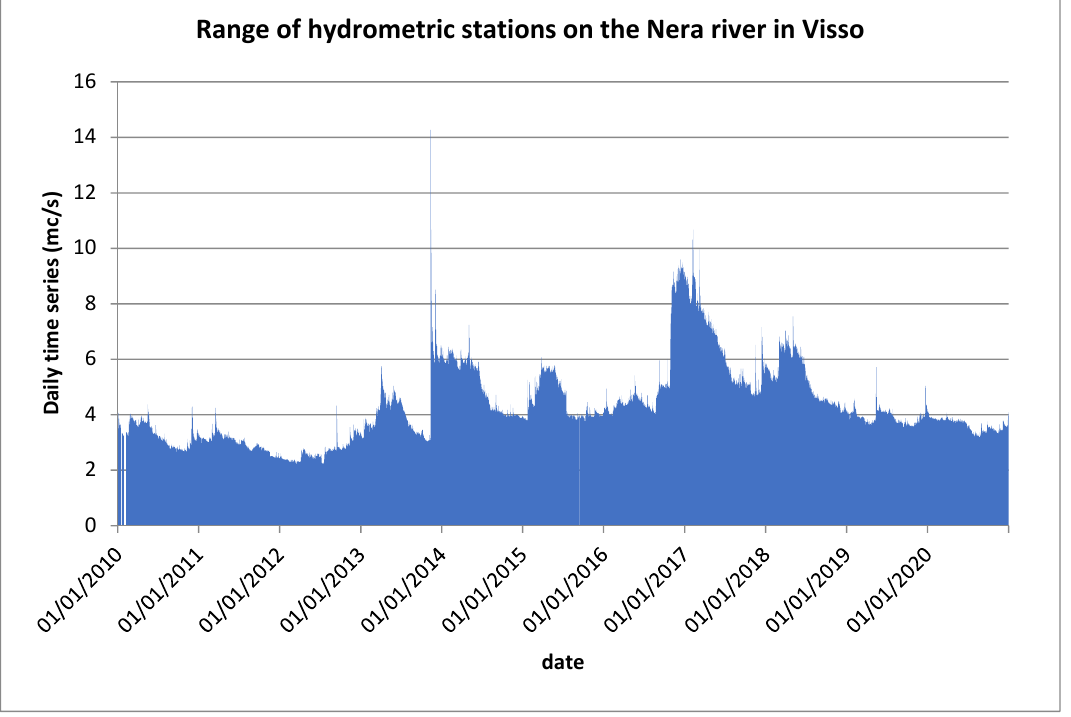
Figure 7. Time series of daily flow rates of the Nera river at Visso. It follows that, rather than a real flooding problem, the snowmelt may affect the groundwater recharge more. In fact, from Figure 7 it can be seen that the highest flows were reached in November 2013, as a result of an event that brought about 300 mm of rainfall, on average, in the area and in correspondence with the October 2016 seismic sequence, which affected the research area.